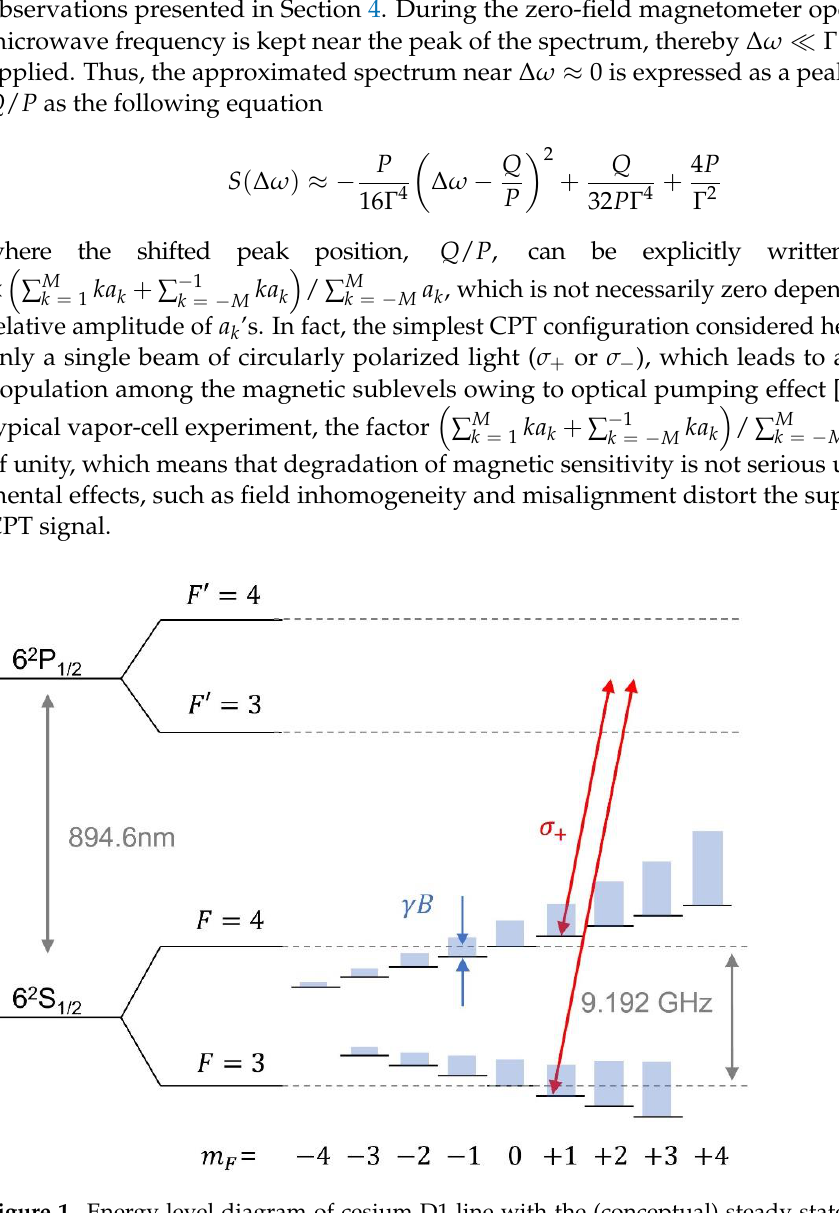
Figure 1. Energy level diagram of cesium D1 line with the (conceptual) steady state population of each magnetic sublevel expressed as height of blue bars. A circularly polarized light (red) is illustrated to create dark state resonance between m F = 1 states as an example. Likewise, each magnetic sublevels can be coupled by an appropriately tuned bichromatic field. Note that the modulation frequency should be half of 9.192 GHz if the bichromatic fields come from two first-order sidebands of a frequency-modulated laser as in our